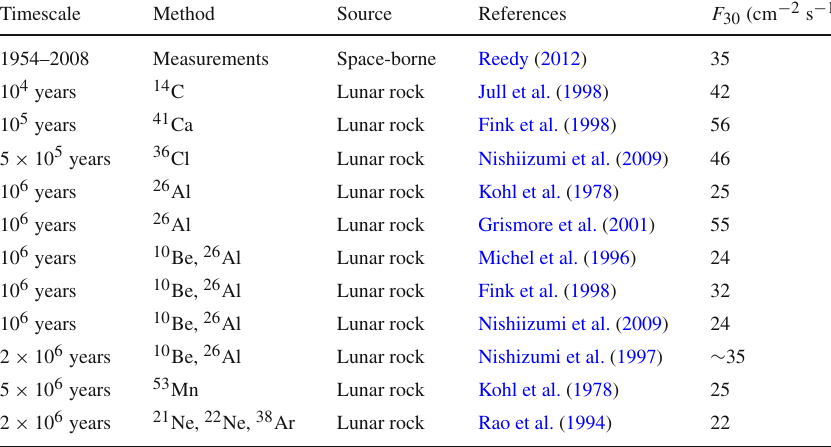
Table 5 Estimates of 4 π omni-directional integral (above 30 MeV) flux, F 30 in (cm 2 s) − 1 , of solar energetic particles, obtained from different sources